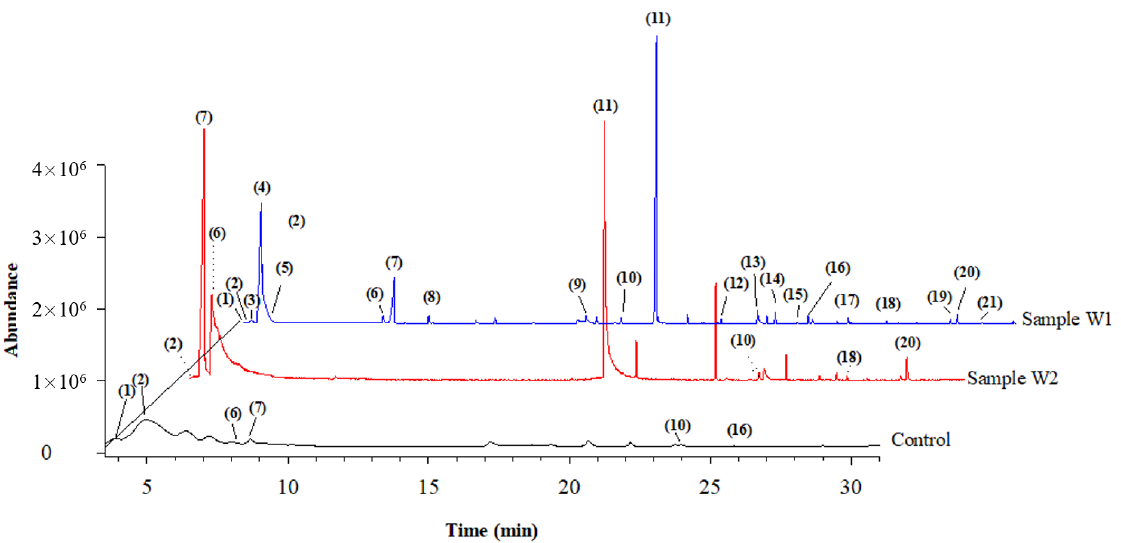
Figure 2. Total ion current chromatograms obtained by the HS-SPME/GC-MS analysis of the three wine samples, i.e., Aglianico wine obtained by fermentation with the mixed starters S. cerevisiae and free cells of H. osmophila (W1); Aglianico wine obtained by fermentation with the mixed starters S. cerevisiae and immobilized cells of H. osmophila (W2); Aglianico wine obtained by fermentation with S. cerevisiae alone (control C). SPME parameters: 100 µ m PDMS fibre, extraction time 20 min, extraction temperature 60 ◦ C, salinity 0.6 g of NaCl in 3 mL of sample volume.